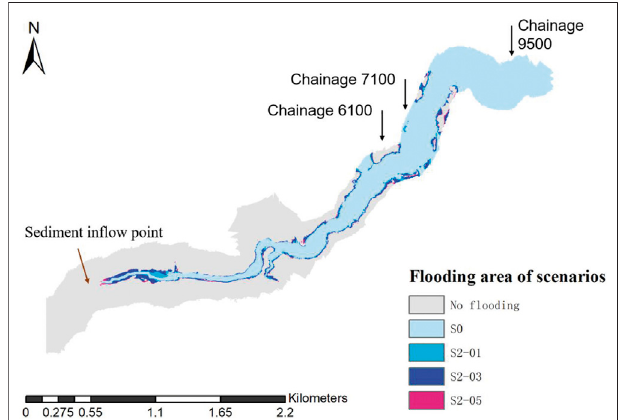
FIGURE7| Floodingareaofdifferentsimulatedscenarios.S0referredto scenario with no sediment in fl ow. S2-01 referred to scenario with sediment in fl ow at the Chainage 5,600 m, with medium particle size of 0.06 m of 1% concentration; S2-03 referred to scenario with sediment in fl ow at the Chainage 5,600 m, with medium particle size of 0.06 m of 3% concentration; S2-05referredtoscenariowithsedimentin fl owattheChainage5,600 m,with a medium particle size of 0. m of 5% concentration.